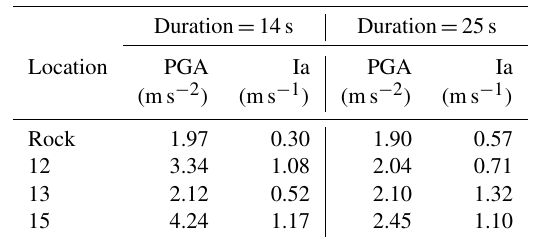
Table 6. PGA and Ia in the profile for the 14 and 25s. Locations 12, 13 and 15 refer to the upper, the middle and the lower blocks, as mentioned in Fig.